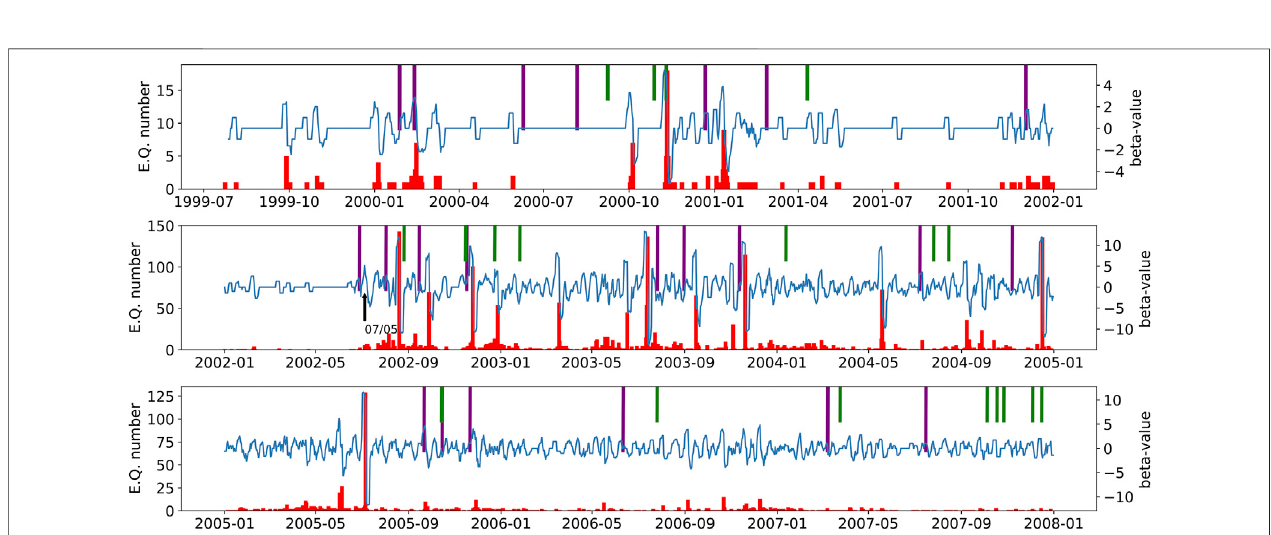
FIGURE 7 | Daily earthquake numbers, β -statistic value from the detected catalog, and occurrence time of deep-focus earthquakes. The x -axis represents the date, the left y -axis the number ofearthquakes per day, and the right y -axis the value ofthe β -statistic. The red bars indicate the number of earthquakes. The purple and green bars indicate deep-focus earthquakes greater than M 6 within 1000 km and earthquakes greater than M 4 within 500 km from Changbaishan volcano, respectively. The blue curves represent time series of the β -statistic, which has been computed with T a (cid:1) 5 days and a sliding window step of 20 days.